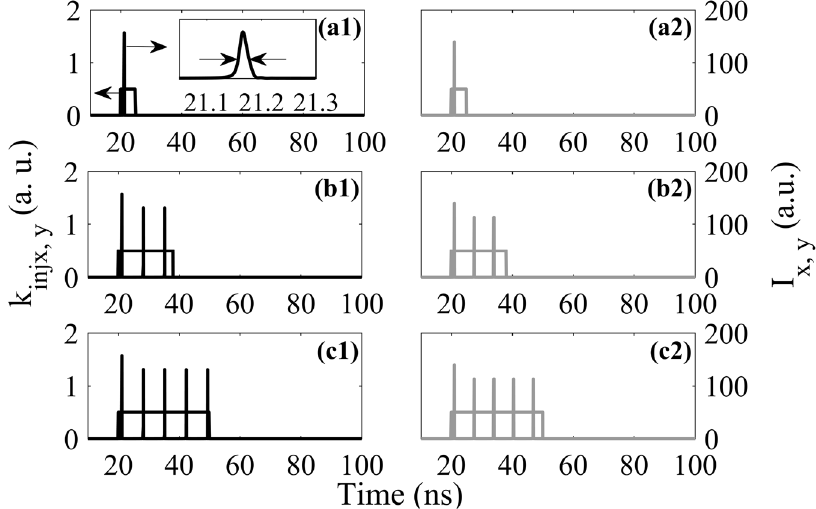
Figure 2. The polarization-resolved responses of VCSEL-SA subject to EIOP. ( a1 )–( c1 ) correspond to the case (i) with the during time 5 ns, 18 ns and 30 ns respectively. ( a2 )–( c2 ) correspond to the case (ii) with the during time 5 ns, 18 ns and 30 ns, respectively. The inset in ( a1 ) indicates an enlargement of the generated